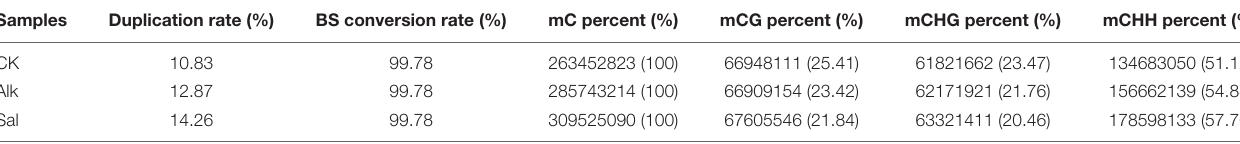
TABLE 2 | Summary of WGBS reads for two different stress conditions.